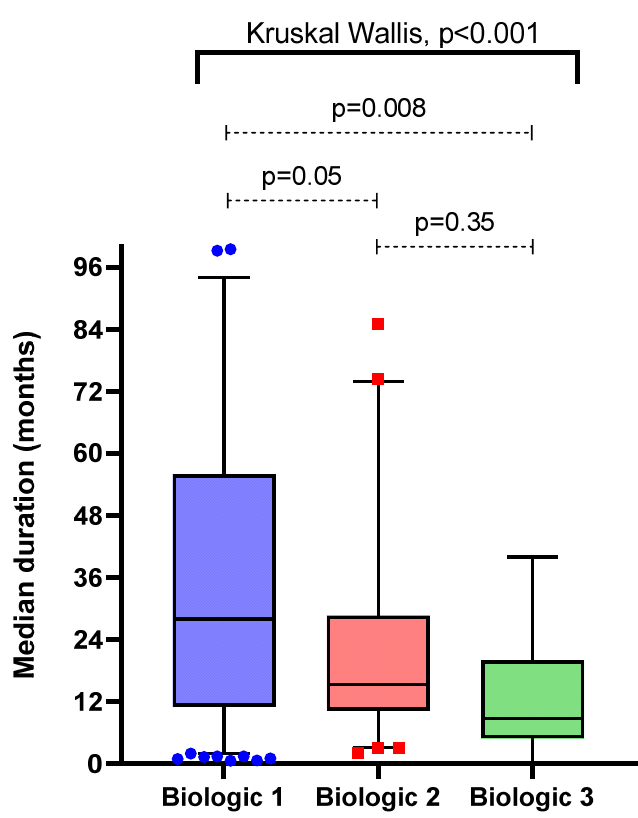
Figure 2. Comparison of treatment persistence per order of biologic (subgroups including only when biologic ceased due to lack of efficacy or intolerance within study follow-up period) .